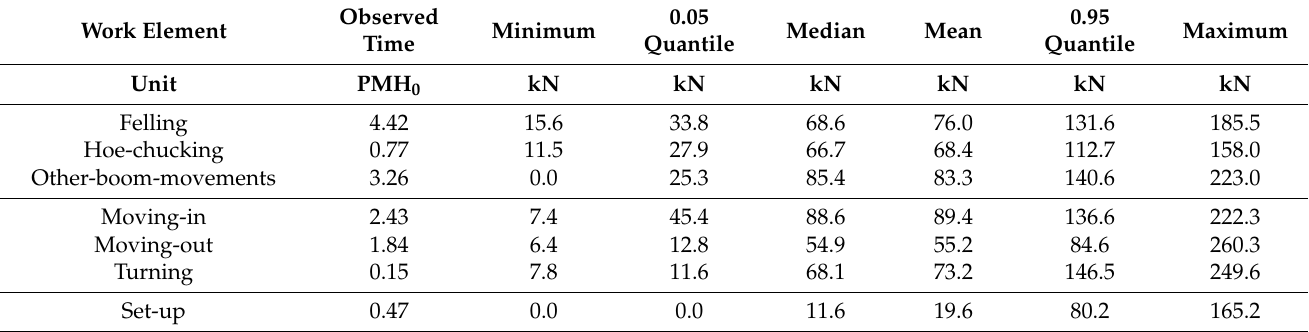
Table 2. Cable tensile forces recorded at the anchor